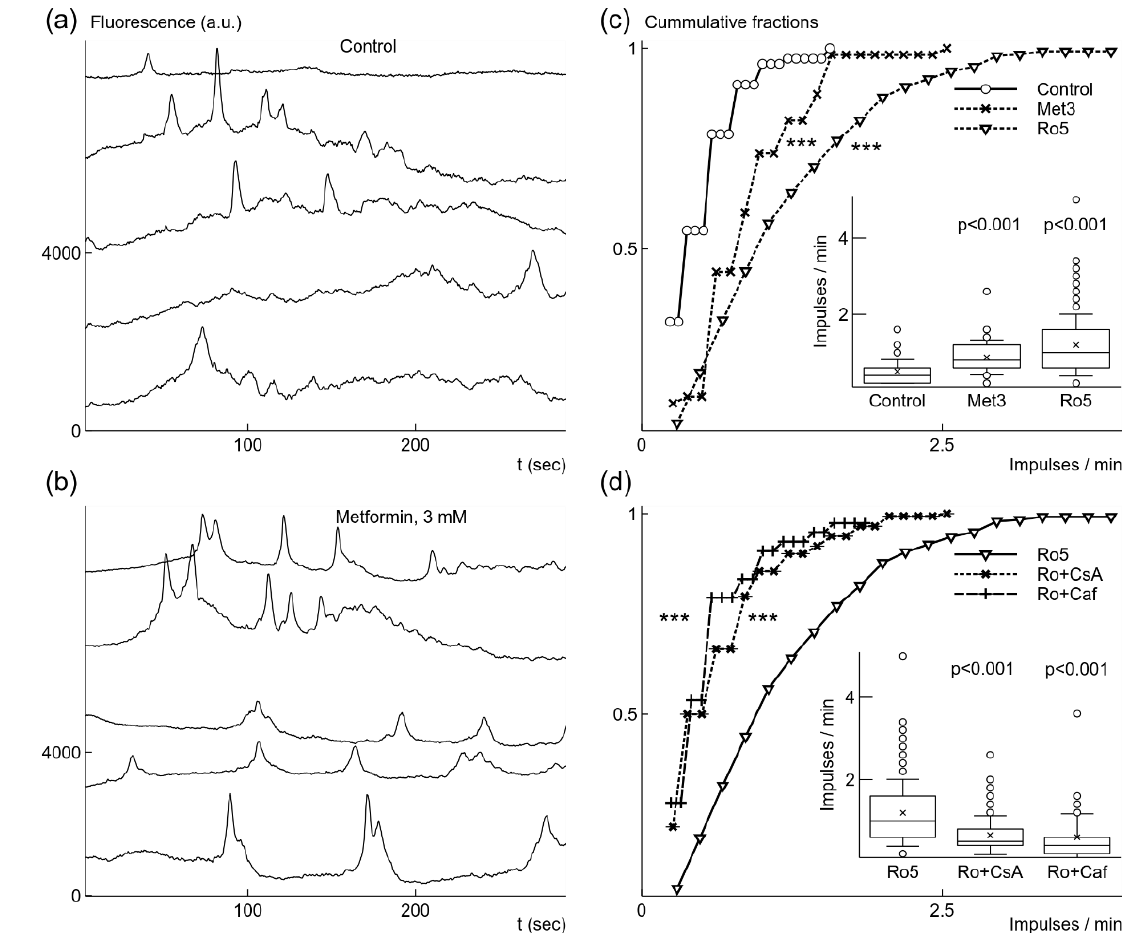
Figure 2. Metformin or rotenone increased the rate of spontaneous generation of fast Ca 2+ signals under normoxic conditions. In control, Ca 2+ signals had low frequency, as shown in fluorescence traces from 5 microglia cells recorded simultaneously ( a ). Addition of 3 mM (Met3) metformin caused more frequent signal generation ( b ). The increase in frequency was statistically significant, which is illustrated as both cumulative probability distributions and box-and-whisker plots (label Met3, inset) ( c ). Even stronger increase in the generation rate was evoked by application of 5 nM rotenone (Ro5) ( c ). When 10 µ M cyclosporin A, CsA (Ro + CsA) was added in the presence of rotenone the rate was significantly reduced ( d ). Similar reduction of the rate was induced by addition of 5 mM caffeine, Caf (Ro + Caf), ( d ). In box-and-whisker plots error bars indicate 1 standard deviation, shoulders of boxes indicate 25–75% intervals, median of data is highlighted by a horizontal line, mean is indicated by a cross, outliers by circles. For cumulative probability distributions *** corresponds to p < 0.001 (Kolmorogov–Smirnov test), p from Welch’s t -test in box-and-whisker plots. Fluorescence traces were shifted by 2000 a.u. in relation to each other for clarity in ( a ) and ( b ).